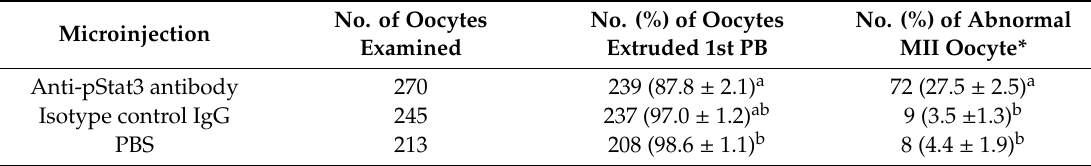
Table 2. E ff ects of anti-pStat3 antibody injection on in vitro maturation.